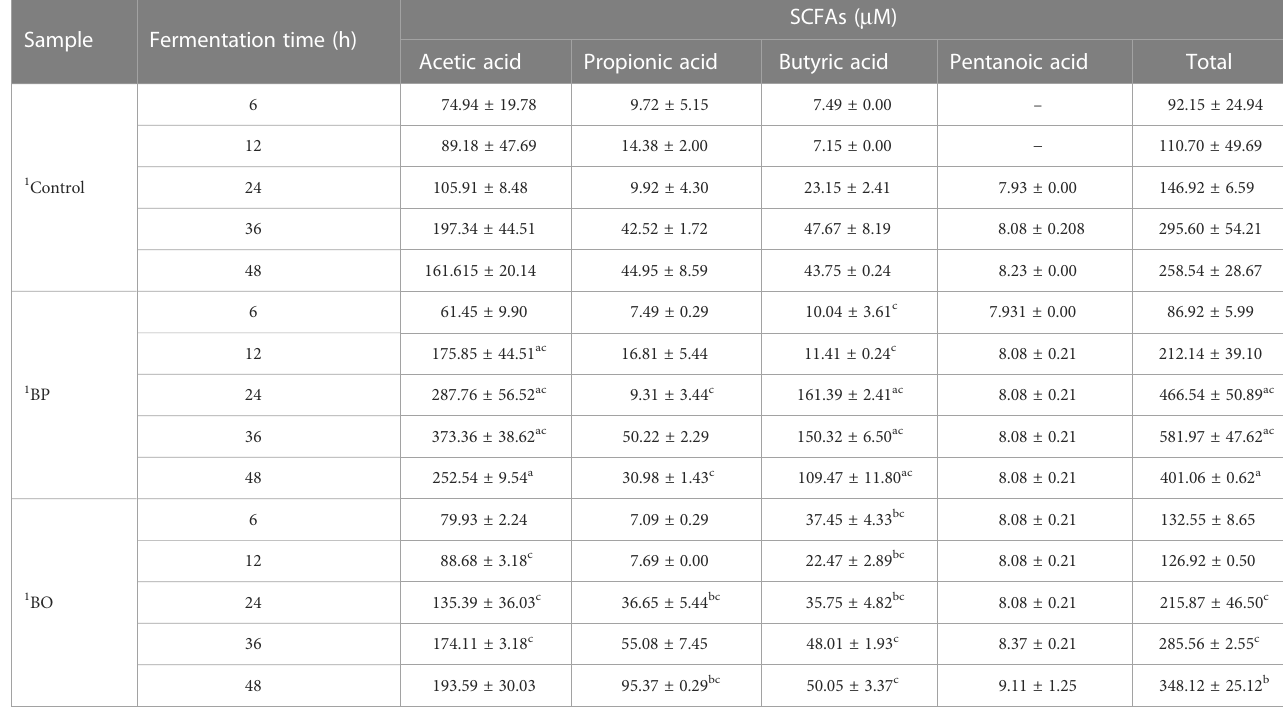
TABLE 2 Concentrations of short-chain fatty acids (SCFAs) in culture medium after gut microbiota fermentation for 0, 6, 12, 24, 36, and 48 h.